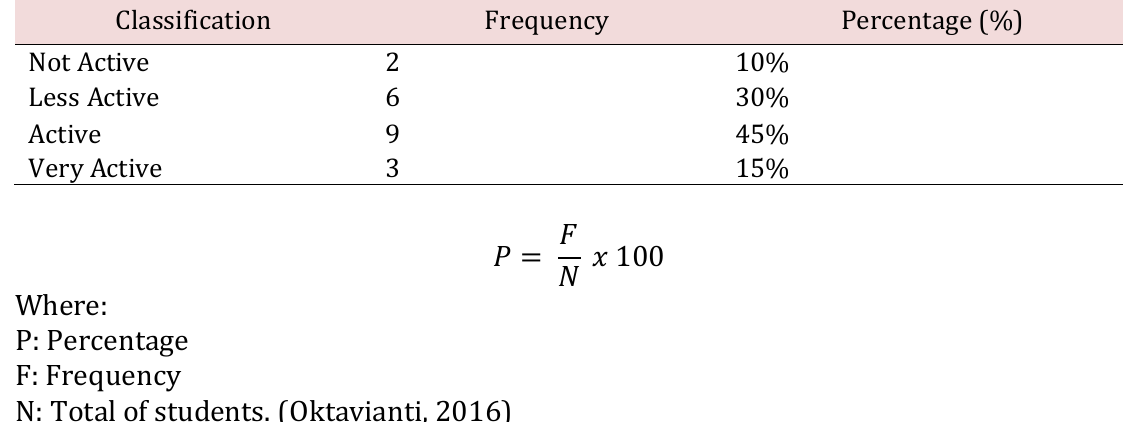
Table 5. The percentage of students' active participation in cycle 1